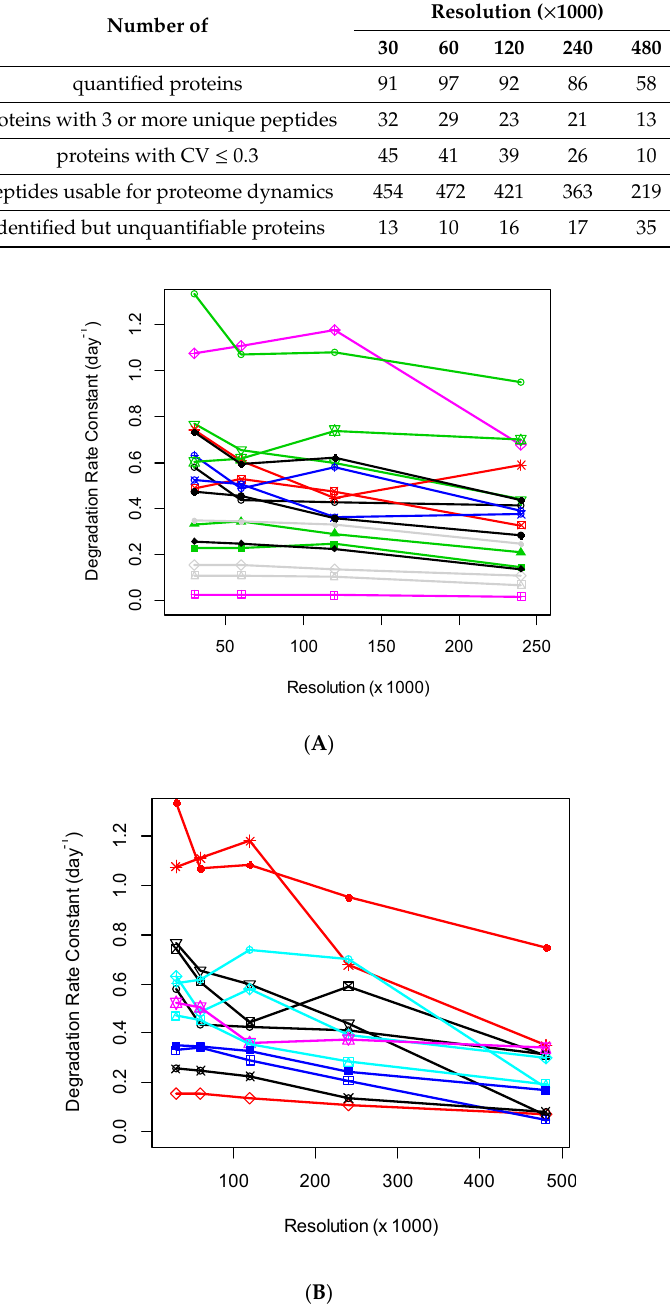
Figure 1. ( A ) Degradation rate constants, which were computed using isotope profiles recorded in the Orbitrap mass analyzer, were relatively stable for mass resolutions up to 120,000. Degradation rate constants were at four different MS 1 level resolutions. Shown are the data for 18 blood serum proteins quantified by at least three peptides in every experiment. The degradation rate constants were produced by d2ome. ( B ) Degradation rate constants of proteins/peptides quantified in Orbitrap mass analyzer were reduced at the mass resolution of 480,000. Degradation rate constants were at five different MS 1 level resolutions. Shown are the data for thirteen blood serum proteins quantified by at least three peptides in every experiment. The degradation rate constants were obtained using d2ome. Each combination of a symbol and color represent the rate constant of a protein at specific